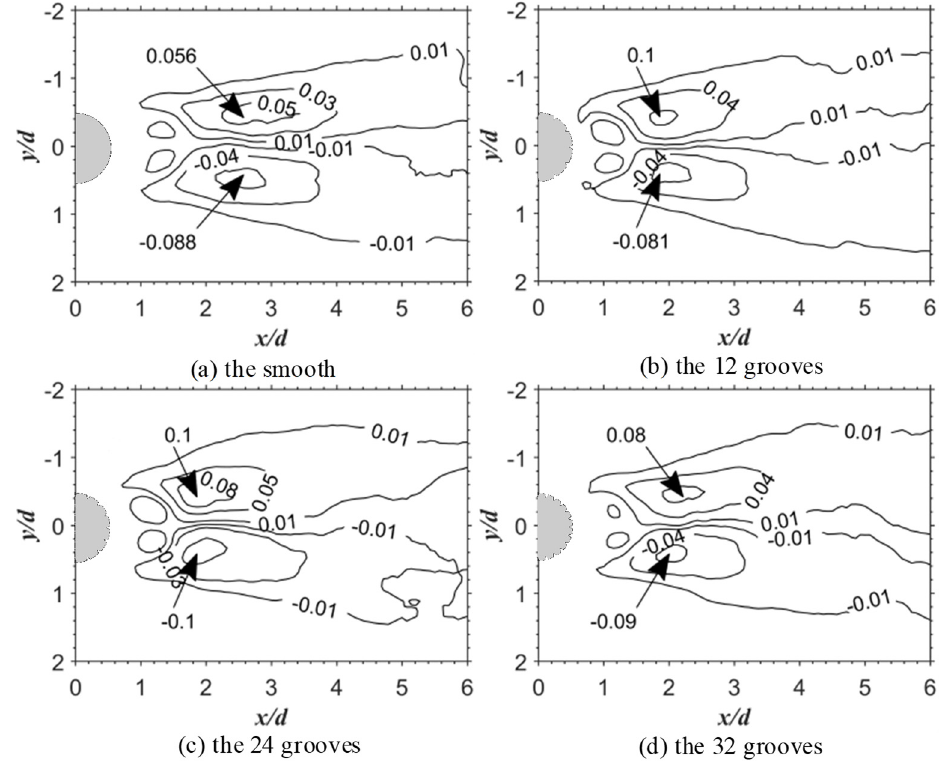
Figure 7. Time-averaged Reynolds shear stress distribution in the ( x, y )-plane.